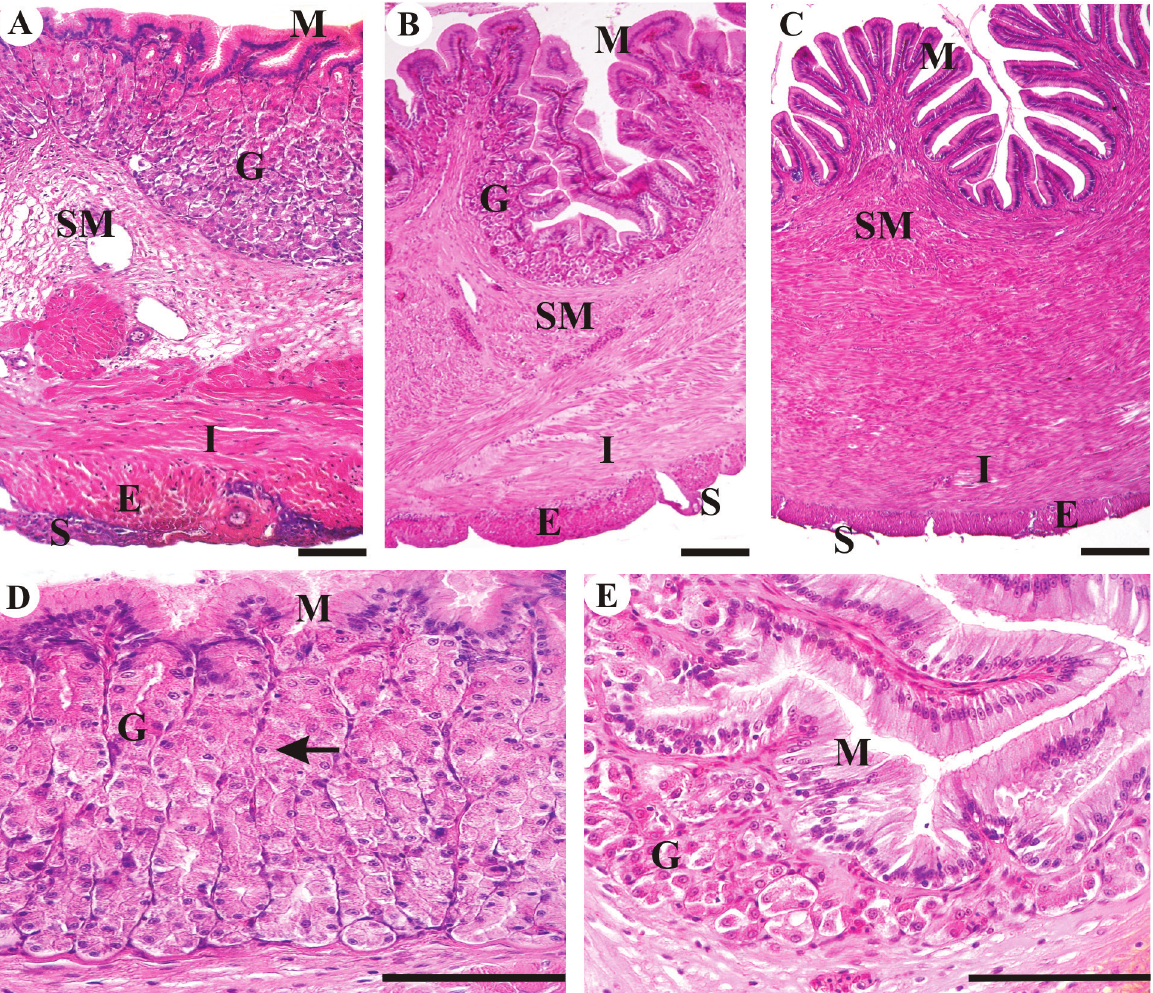
Fig. 2 - Histological organization of the three regions of the stomach: (A). Cardiac region and (B). Fundic region showing the mucosa (M), gastric glands (G), submucosa (SM), internal muscular layer (I), external muscle layer (E), serosa (S), HE (bar = 500 μm). (C). Pyloric region highlighting the mucosa (M), submucosa (SM), internal muscle layer (I), external muscle layer (E), serosa (S), HE (bar = 500 μm). (D). Detail of the cardiac region showing the mucosa (M), gastric glands (G) and oxynthic and peptic cells (arrow), HE (bar = 200 μm). (E). Detail of the fundic region showing the mucosa (M), gastric glands (G), HE (bar = 200